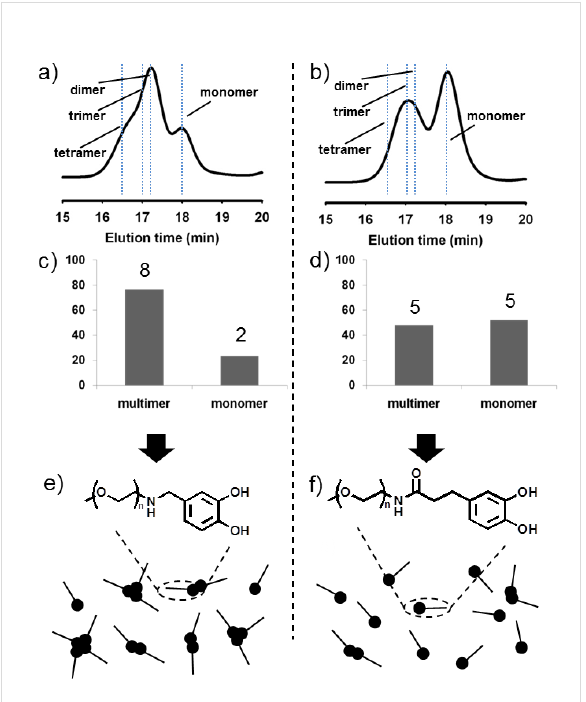
Figure 2: Comparative analysis of crosslinking products of mPEG-NH- catechol and mPEG-catechol. (a,b) GPC data obtained from crosslinking at a stoichiometric ratio of NaIO 4 :catechol = 1.5:1. The dot lines indicate each elution time of PEG standards with molecular weight of 5, 10, 15, and 20 kDa. The quantitative multimeric and monomeric ratio of crosslinked mPEG-NH-catechol and mPEG-cate- chol were shown in (c) and (d). (e,f) Schematic results comparing nanoscale junctions formed by (e) mPEG-NH-catechol and (f) mPEG-